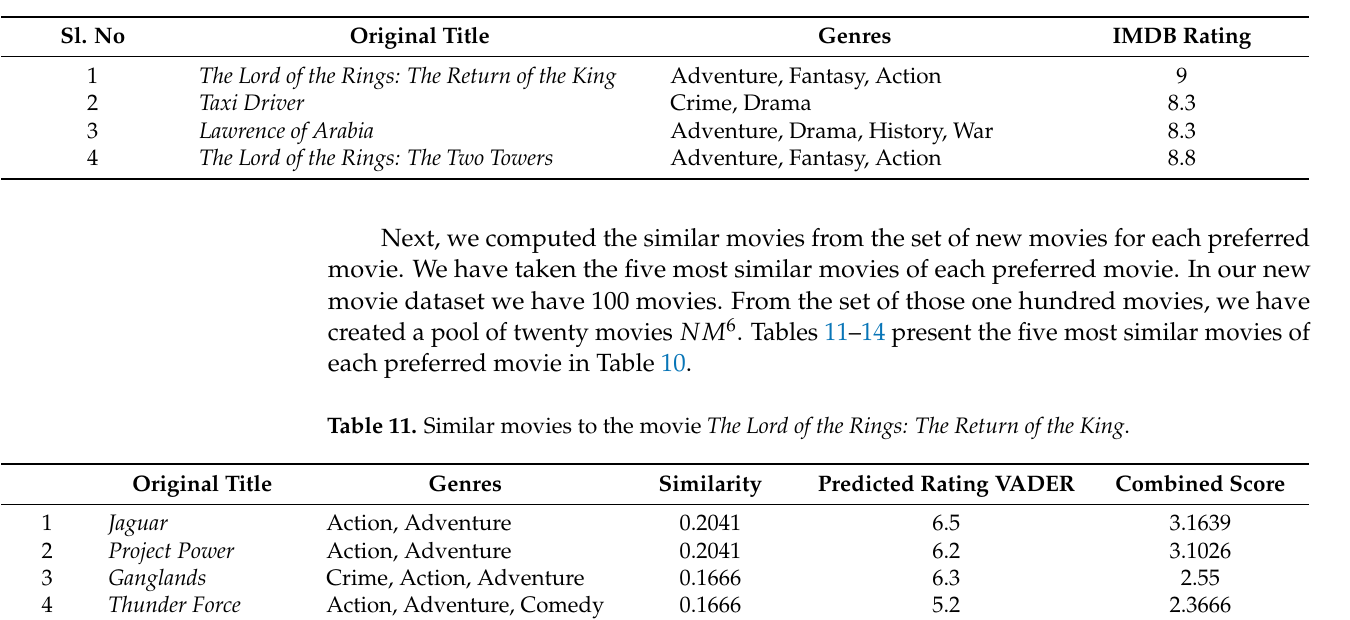
Table 10. Preferred movie set of a user.